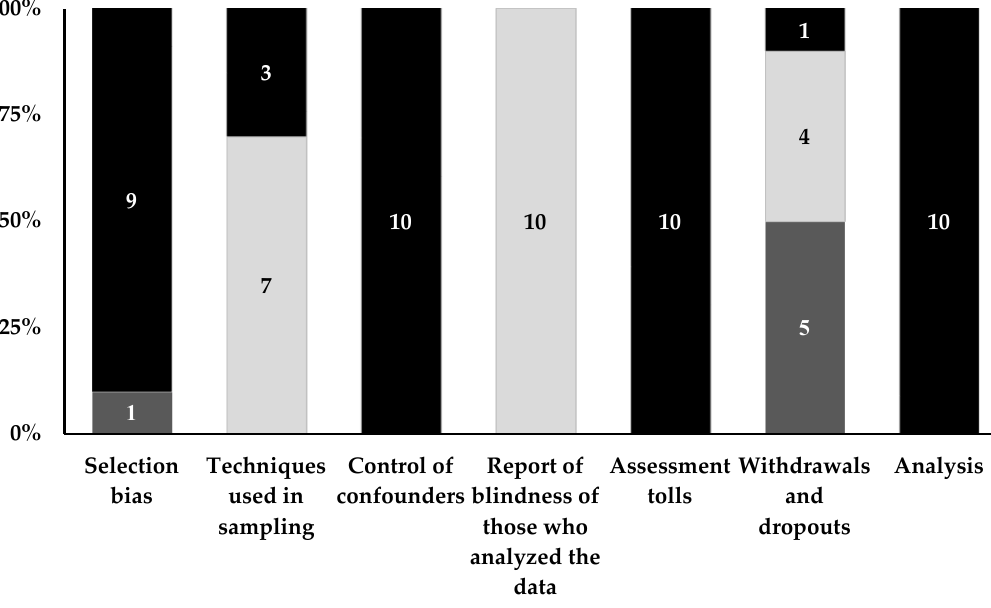
Figure 2. Risk of bias assessment of included articles (Black: low; Light grey: moderate; Dark grey: high). The numbers within the bars indicate the number of articles that were classified in the risk of bias